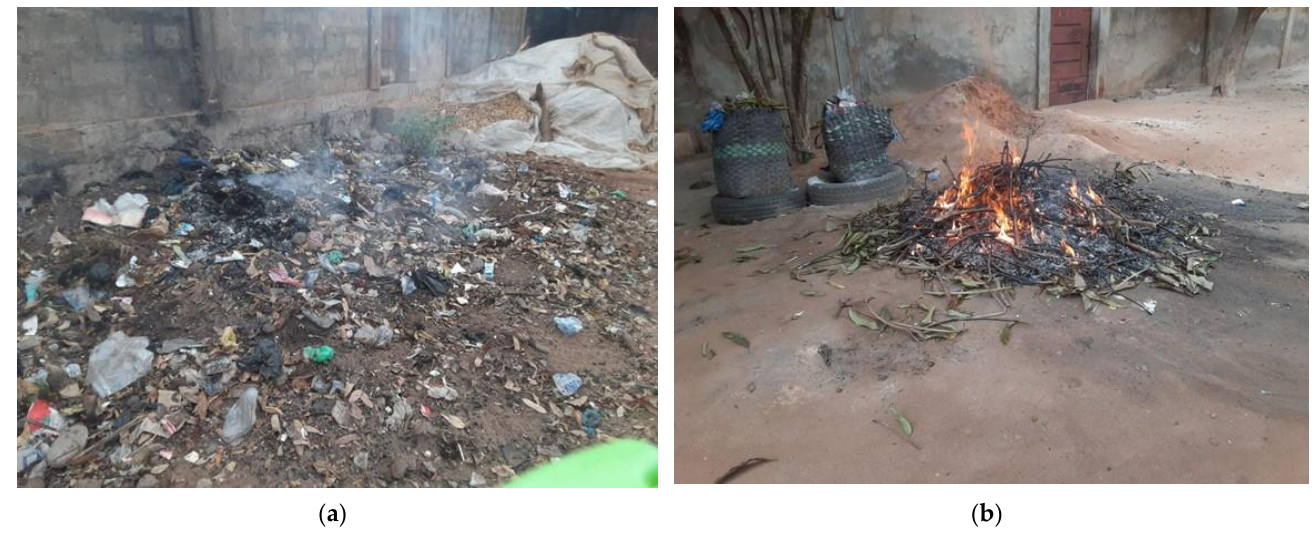
Figure 1. Waste management practices used by citizens in Togo: ( a ) Example of litter management by local citizens with no access to organized waste disposal; ( b ) Example of burning waste plastic with organics. Note the plastic waste in the garbage bins about to be burned.